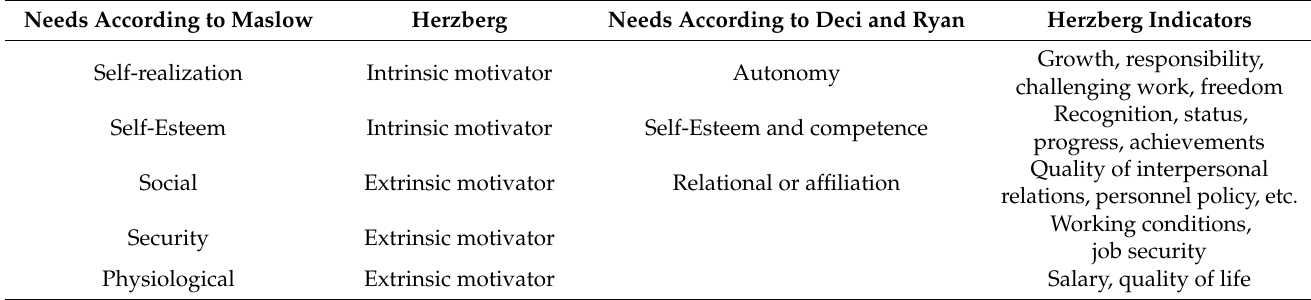
Table 1. Needs/motivators